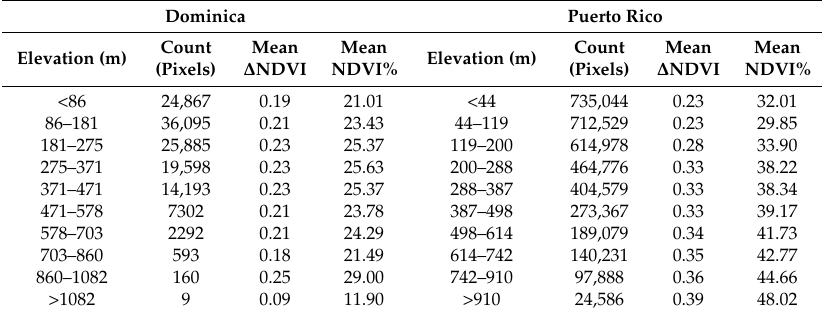
Table 7. The vegetation index statistics of different elevation for Dominica and Puerto Rico.